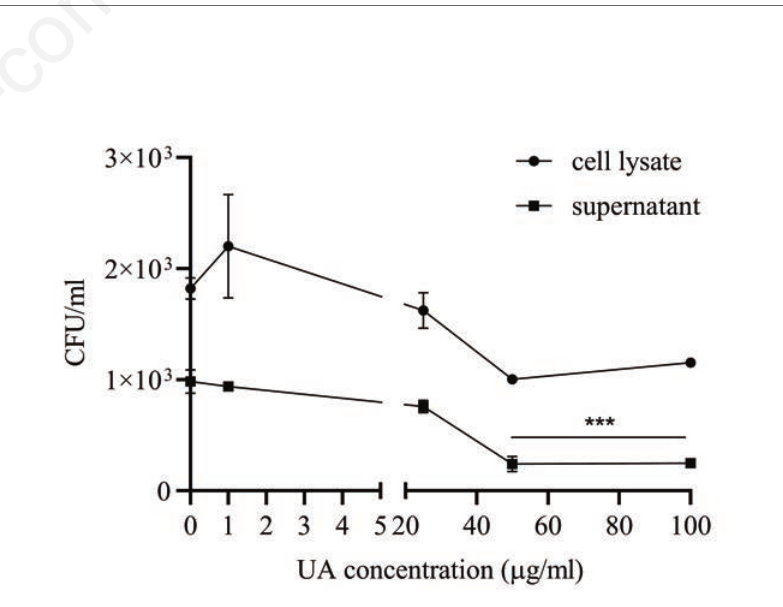
Figure 4. Colony-forming units (CFU) of Mycobacterium avium in model 3. The results are described as mean of ± SD, with each experiment performed in triplicate; ***p<0.001. Effect of UA on phosphorylation of ERK1/2, P38, and SAPK/JNK during infection of murine macrophages with Mycobacterium